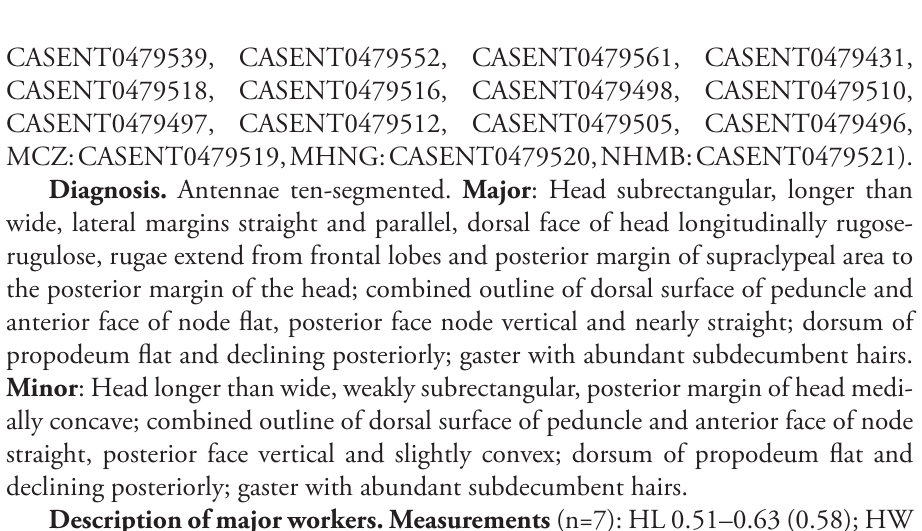
Figure 34. Carebara betsi –holotype. Major worker, CASENT0479444. A head in full-face view B body in profile view C body in dorsal view. Minor worker, CASENT0479432 D head in full-face view E body in profile view F body in dorsal